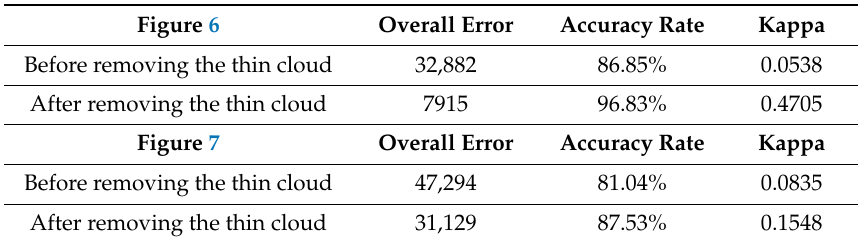
Table 2. Image change test results.